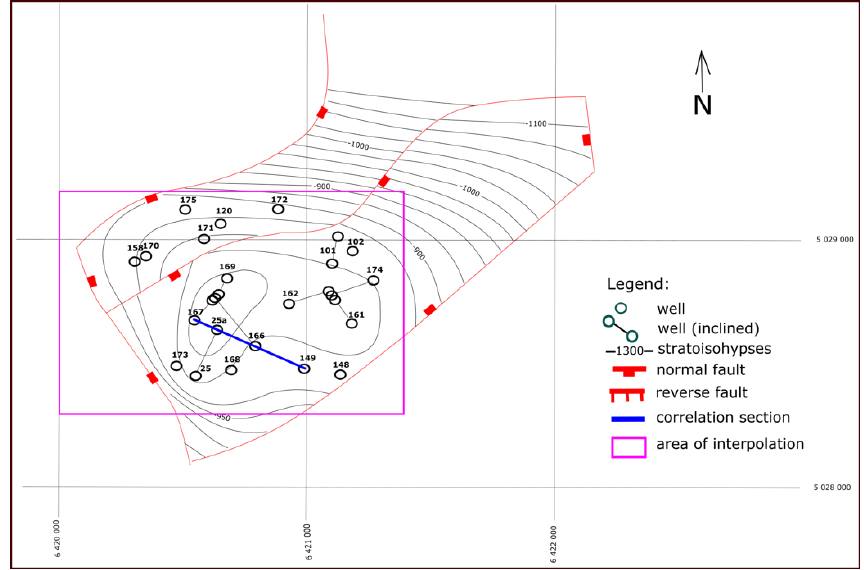
Figure 2. A structural map of the Late Miocene (Lower Pontian) reservoir "K".